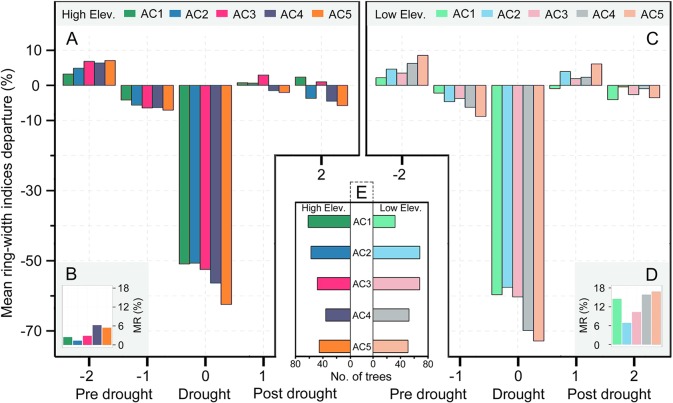
The percent of mean tree-ring width indices’ anomalies relative to the average values during the 2 years (lag-2 to lag-1 years) prior to each drought event for Qilian juniper at high (A) and low altitude (C), respectively. The graphs in the lower corners (B, D) represent the percent of missing rings during drought years compared to all tree-ring width data for the four drought years. The middle lower panel (E) represents the age structure of the trees used in this study at high and low altitudes, respectively.